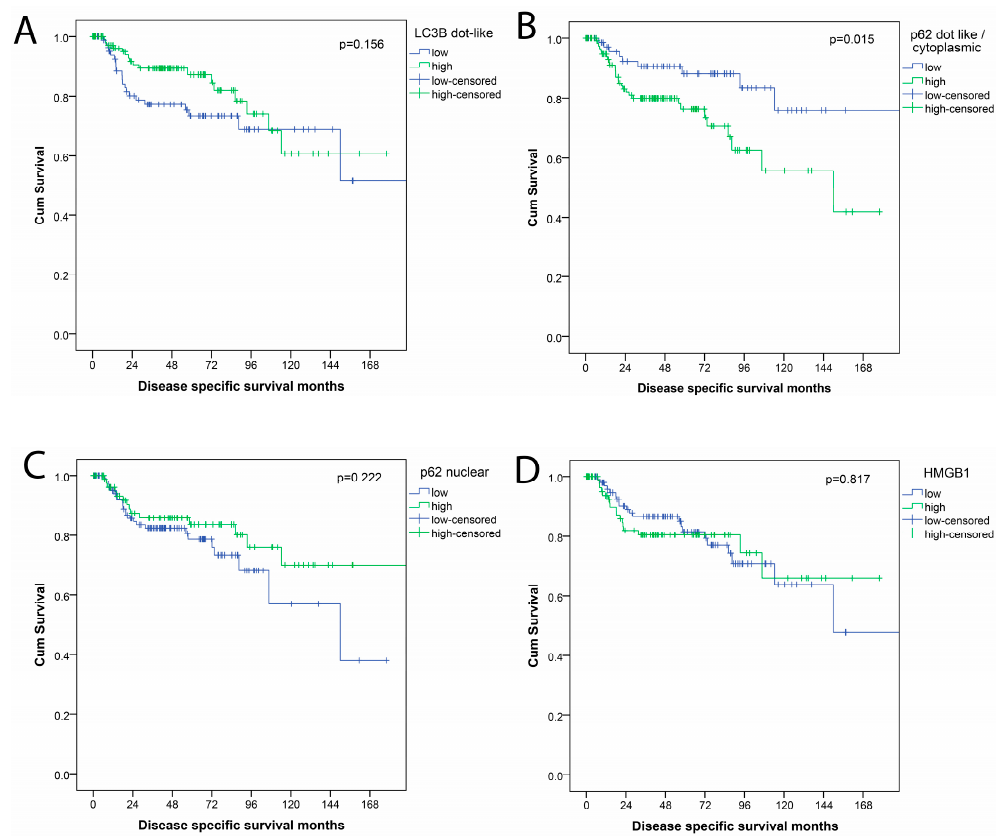
Figure 3. Survival curves (disease free survival) for expression of autophagy related proteins ( A ) LC3B; ( B ) p62 dot-like/cytoplasmic; ( C ) p62 nuclear; ( D ) HMGB1.